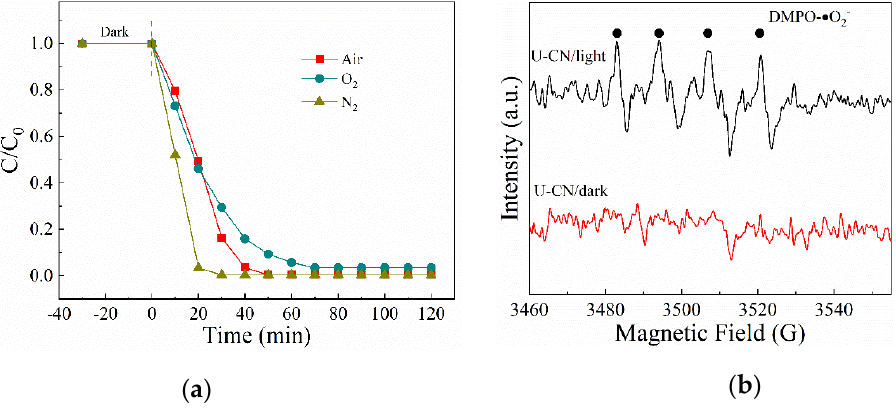
Figure 9. ( a ) Photocatalytic reduction of Cr(VI) in air and N 2 ambient; ( b ) ESR spectrum of • O 2 − .